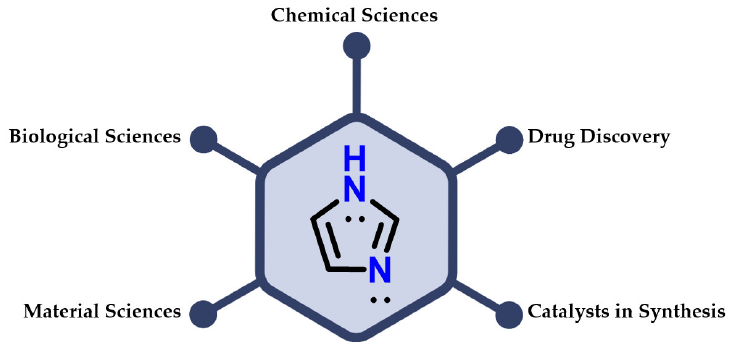
Figure 3. Applications of imidazole 1 in different areas of knowledge.